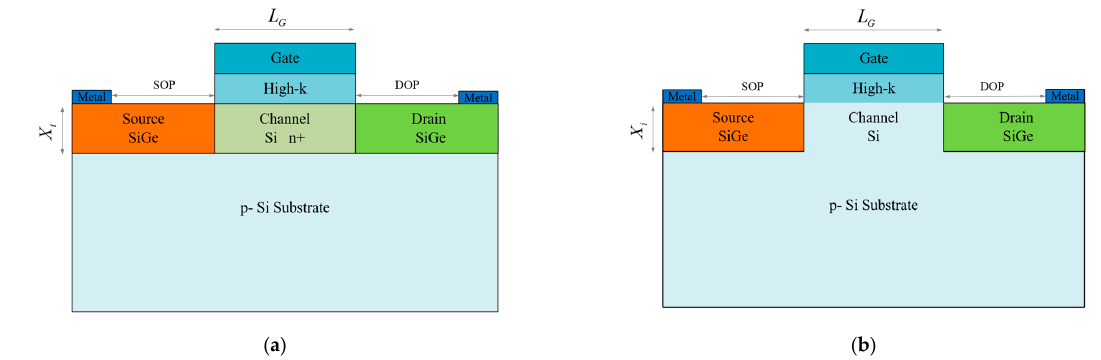
Figure 2. ( a ) device structure of PNN TFET and ( b ) Conventional TFET. Transmission line pulse(TLP) is a kind of non ‐ destructive equivalent ESD impact test, which can accurately obtain the ESD characteristic parameters of the device. The drain terminal of the TFET was stressed with TLP pulses while keeping the gate and the source terminals grounded. The rise time and the pulse width were set as 10 ns and 100 ns. The voltage samples were obtained by averaging the transient data in the range of 60 ns to 90 ns [16].